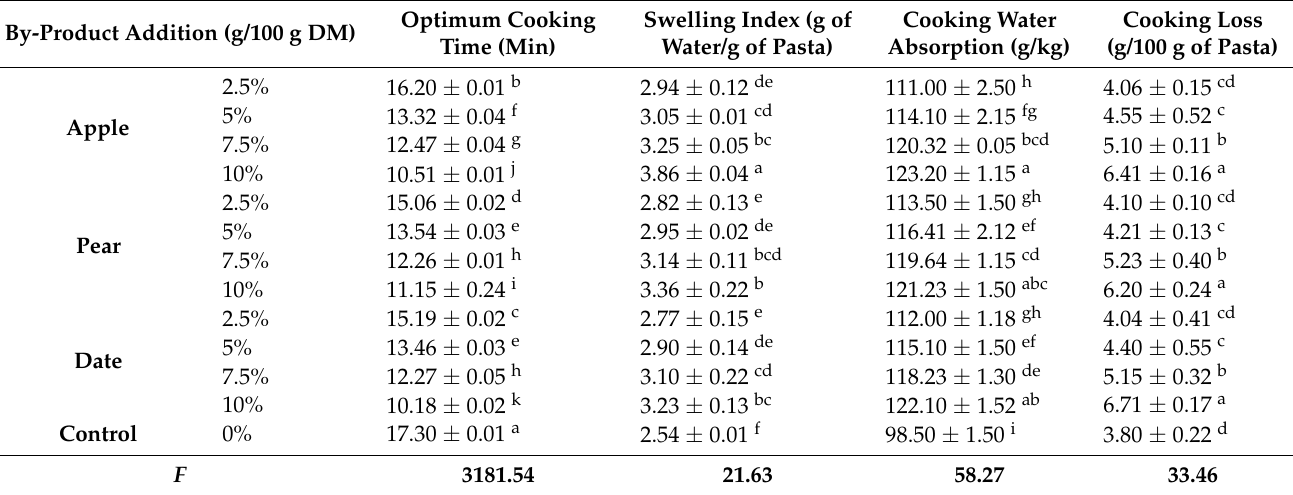
Table 2. Cooking properties of enriched